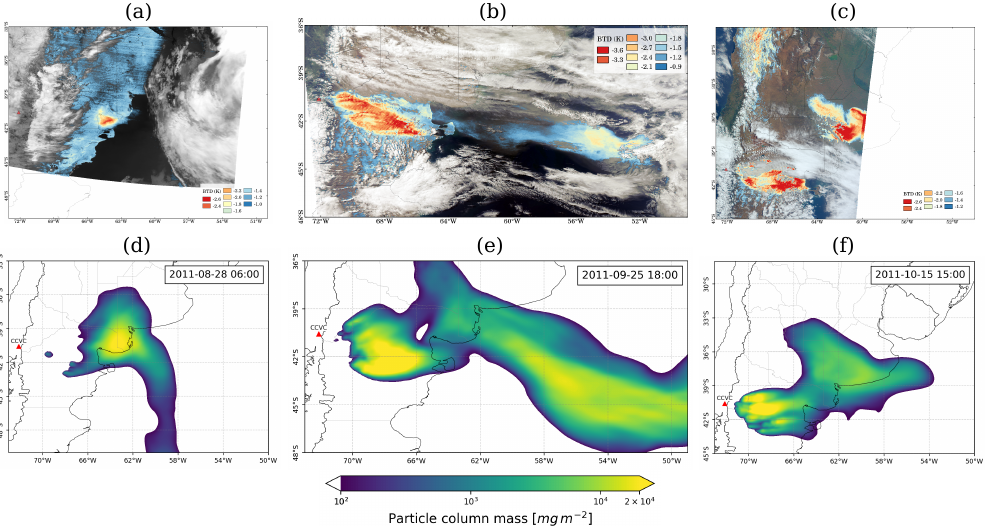
Figure 16. MODIS satellite imagery ( a – c ) and FALL3D column mass ( d – f ). The BTD (brightness temperature difference) method is used to detect airborne volcanic ash for: ( a ) 28 August 2011 at 05:30 UTC; ( b ) 25 September 2011 at 17:55 UTC and; ( c ) 15 October 2011 at 14:55